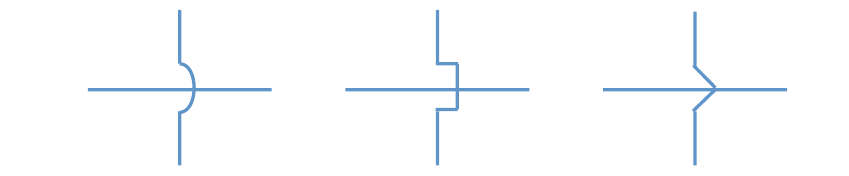
Figure 17: Examples of Interaction crossover patterns.